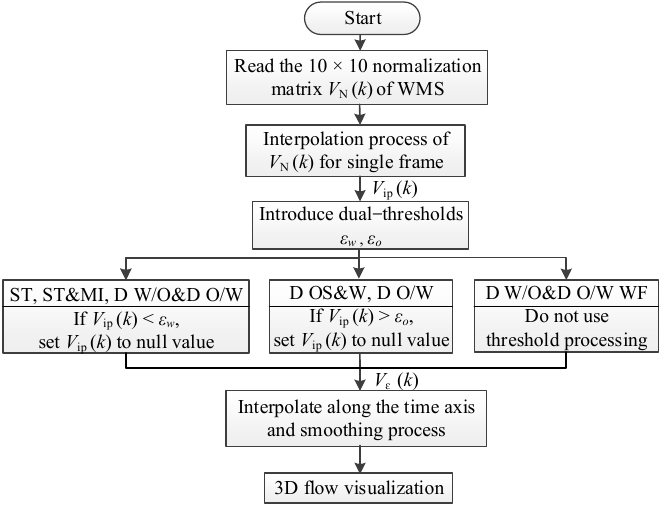
Figure 9. Flow chart for the preprocessing of the sensor response signal.